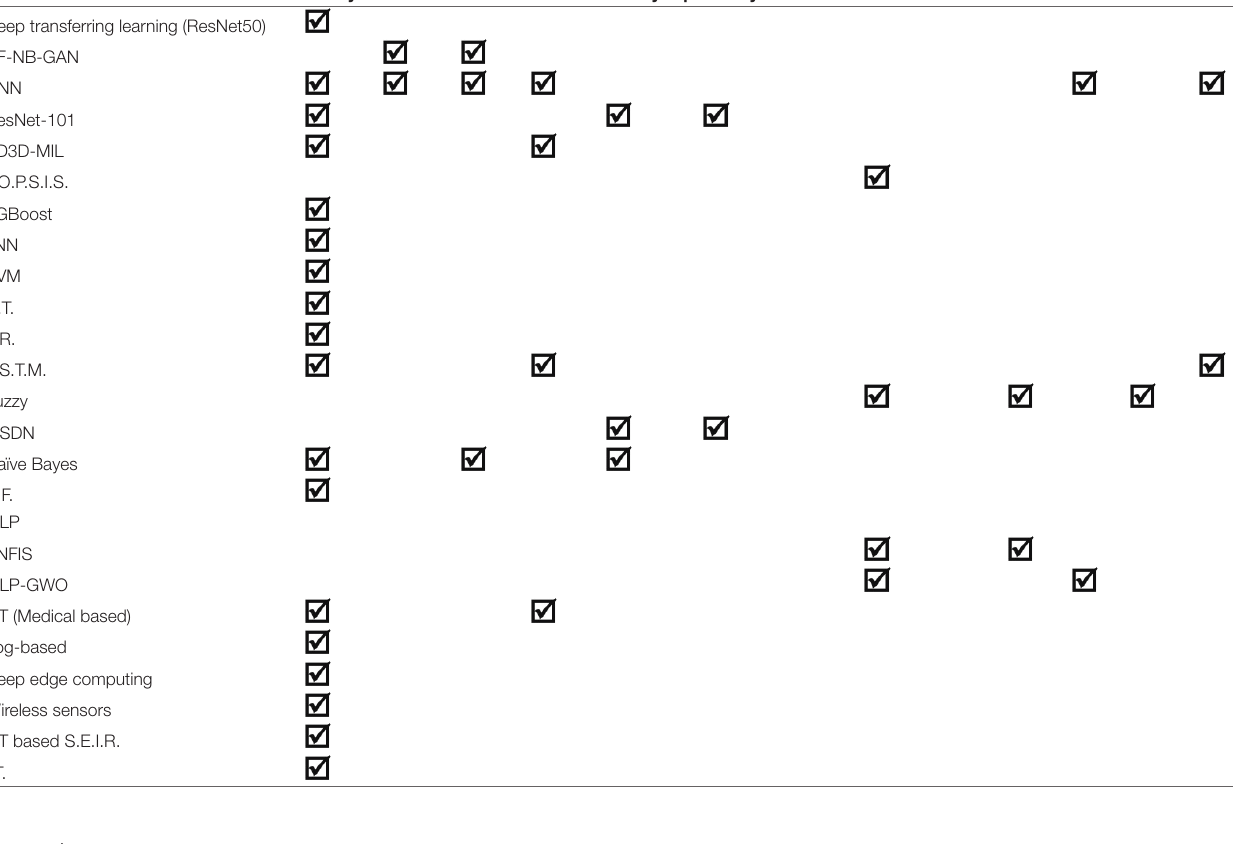
TABLE 6 | The main contribution of ML-based techniques in COVID-19 applications. Prediction Monitoring